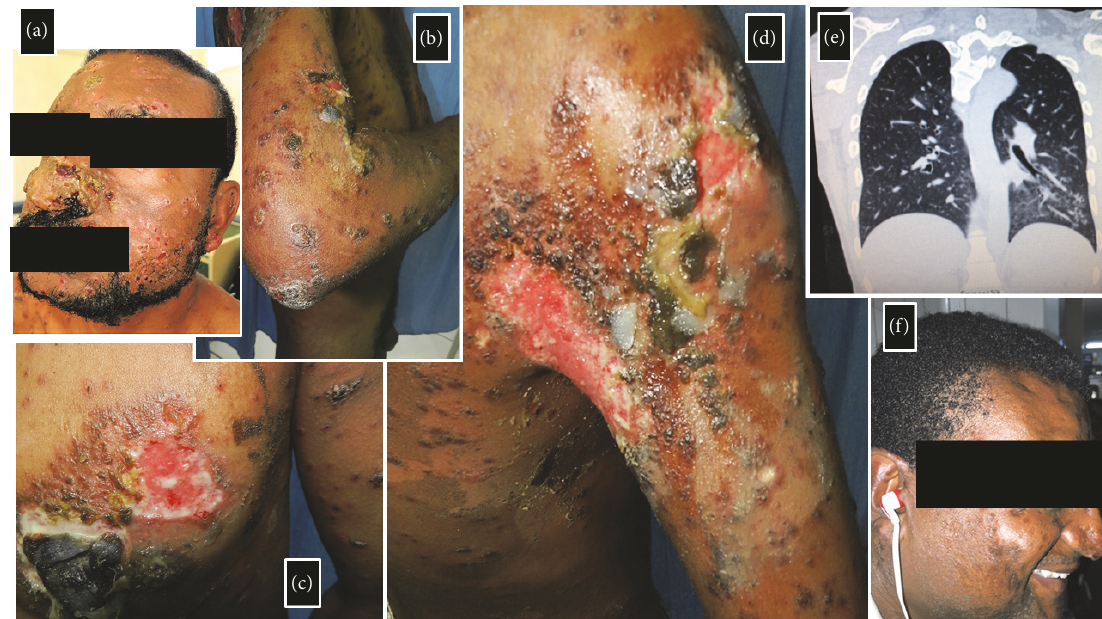
Figure 1: Clinical images of our 34-year-old male patient who presented with a 2-month history of rapidly spreading multiple cutaneous lesions. Annular brownish papules and plaques, with or without a scale crust, scattered over the face (a), chest (c/d), and extremities (b/d). Some larger lesions assumed a rupioid aspect (c). Large reddish shallow ulcers in right mammary (c) and right anterior axillary (d) regions. Somelesionsdrainedaseropurulentdischarge.Groundgrassopacitiesareseenoverthesuperiorsegmentoftheleftinferiorlobe(e).Complete remission of cutaneous lesions after treatment (f).